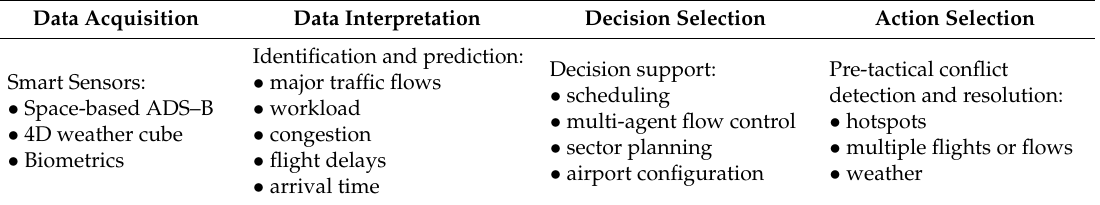
Table 7. Categories of automation applied to ATFM (from [48]). ADS–B—automatic dependent surveillance–broadcast;